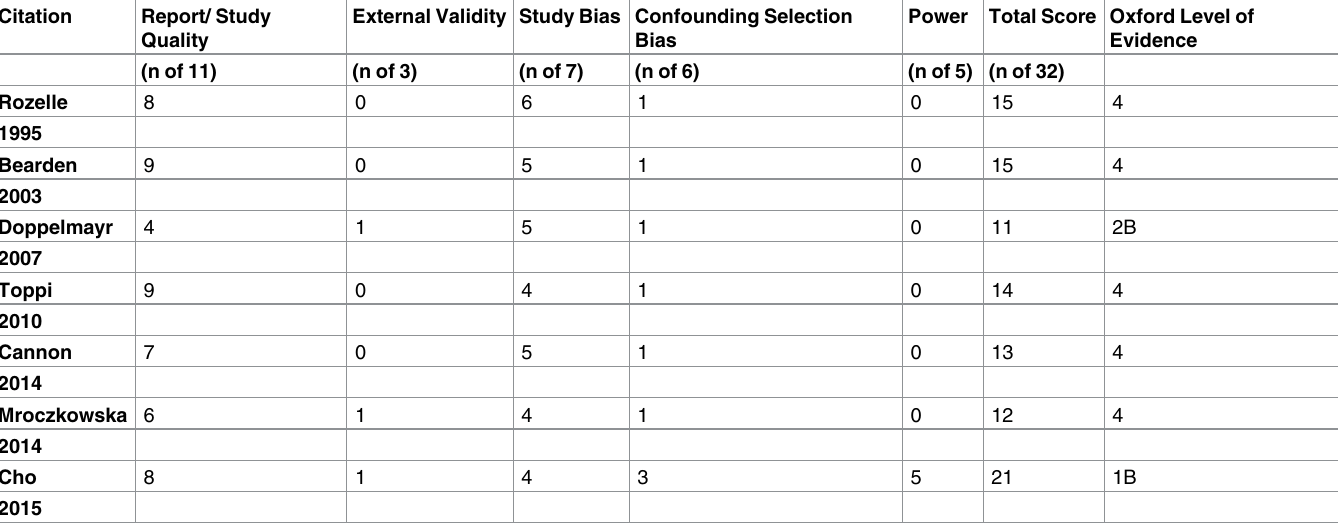
Table 3. Downs & Black Critical Appraisal Score & Oxford Level of